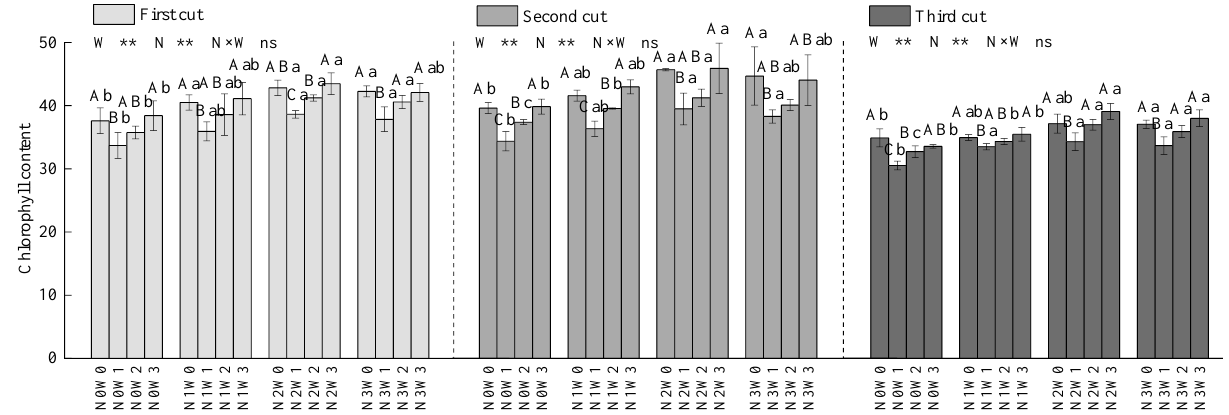
Figure 7. Effects of water-nitrogen regulation on chlorophyll content of Bromus inermis . Different capital letters indicate the difference between different irrigation management types under the same nitrogen application level, and different lowercase letters indicate the difference between different nitrogen application levels under the same irrigation management ( p < 0.05). W and N refer to irrigation management and nitrogen application level, respectively; N × W refers to interaction effect between the two. ** indicates an extremely significant difference ( p < 0.01); ns indicates no significant difference ( p >